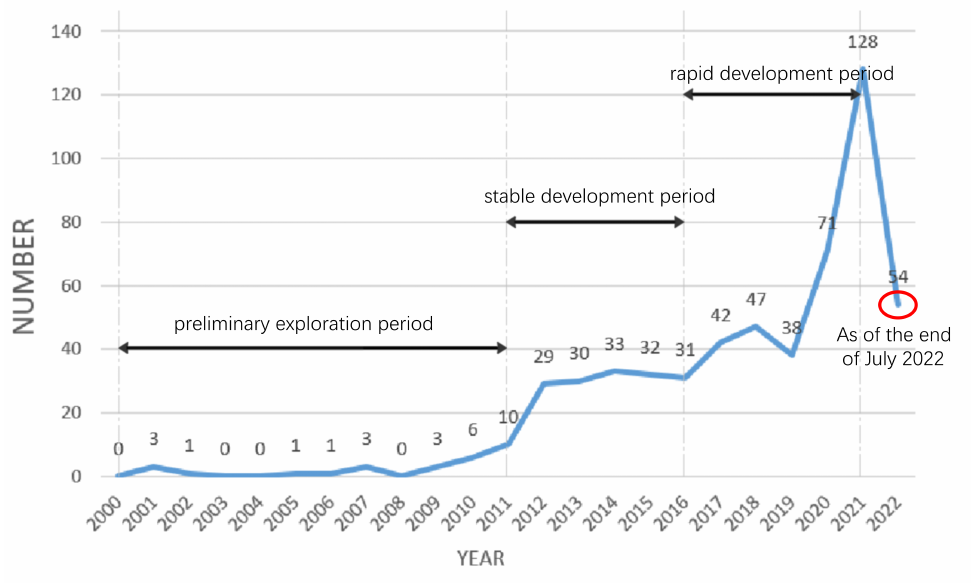
Figure 2. The number of articles on carbon emissions in the construction